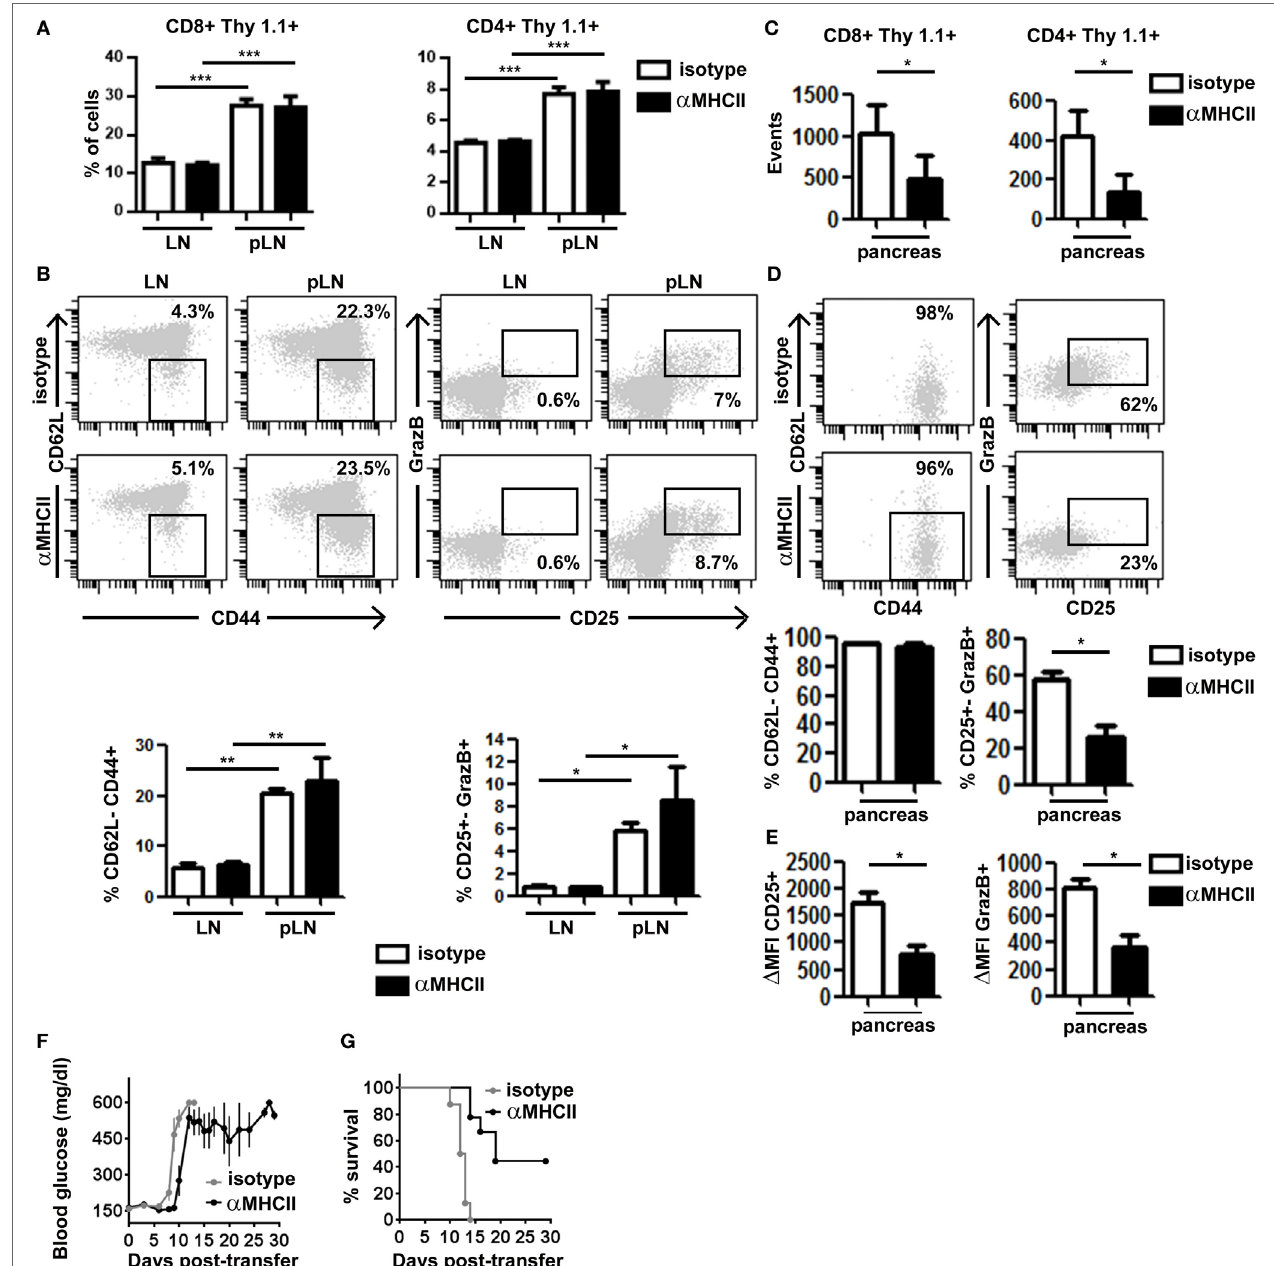
FigUre 4 | Major histocompatibility complex (MHC) class II-dependent CD4 + T cell help supports CD8 + T cell effector function in the pancreas. Irradiated InsHA-mCherry mice transferred with clone 4-GFP CD8 + and HNT-CFP CD4 + T cells were treated on days 8 and 9 with either anti-MHCII- or isotype-matched control mAb and sacrificed on day 10. (a) Detection of Thy1.1 + donor clone 4-GFP CD8 + and HNT-CFP CD4 + T cells in LN and pLN. Values represent mean ± SEM of the percentages of donor T cells in singlets living lymphocytes ( n = 5 mice/group, Mann–Whitney U -test). (B) Phenotype of CD8 + Thy1.1 + donor lymphocytes in the LN and pLN of representative individual mice. Graphs depict percentages of different subpopulations of donor CD8 + T cells. Values correspond to mean ± SEM ( n = 4 mice/group, Mann–Whitney U -test). (c) Detection of Thy1.1 + donor clone 4-GFP CD8 + and HNT-CFP CD4 + T cells in the pancreas. Values represent mean ± SEM of total detected events from individual pancreas ( n = 5 mice/group, Mann–Whitney U -test). (D) Phenotype of clone 4-GFP CD8 + Thy1.1 + donor lymphocytes in the pancreas of representative individual mice. Graphs depict percentages of different subpopulations of donor clone 4-GFP CD8 + T cells in the pancreas. Values correspond to mean ± SEM ( n = 3–5 mice/group, Mann–Whitney U -test). (e) Graphs depict the mean fluorescence intensity (MFI) of CD25 and granzyme B (GrazB) minus that of matched isotype control staining in the CD8 + Thy1.1 + CD25 + GrazB + T cell subpopulations described in (D) . Values represent mean ± SEM ( n = 3–5 mice per group, Mann–Whitney U -test). Data from one representative experiment of two, Mann–Whitney U -test. (F) Irradiated InsHA-mCherry mice transferred with clone 4-GFP CD8 + and HNT-CFP CD4 + T cells were treated from day 8 posttransfer every 3 days with either anti-MH II- or isotype-matched control antibody. Blood glucose levels over time post-T cell transfer, mean ± SEM ( n = 9 mice/group, two independent experiments). (g) Survival curve of mice described in (F)